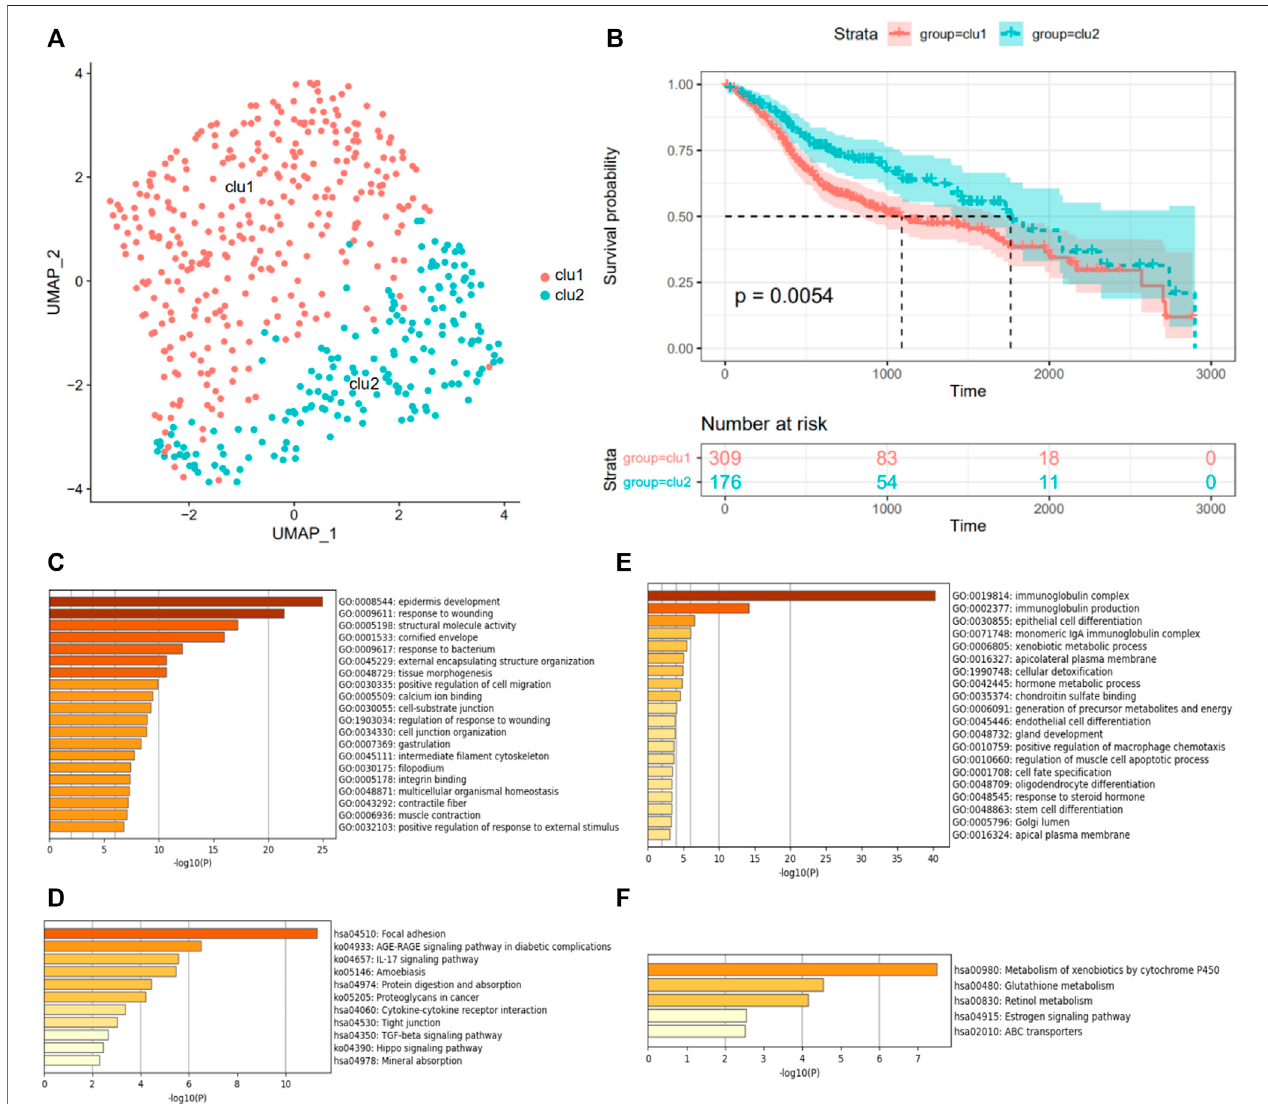
FIGURE2| GroupingofpatientsaccordingtoFGFRsignalingpathway. (A) TheUMAPalgorithmclassi fi esHNSCCpatientsintotwoclusters,indicatedbydifferent colors. (B) The survivorship analysis plot of OS in two clusters. GO function enrichment (C,E) and KEGG pathway enrichment analysis (D,F) of differentially expressed genes in the fi brosis low-survival group, colored by p -values. (C,D) Analysis of the high expression genes in the fi brosis low-survival group. (E,F) Analysis of the low expression genes in the fi brosis low-survival group.